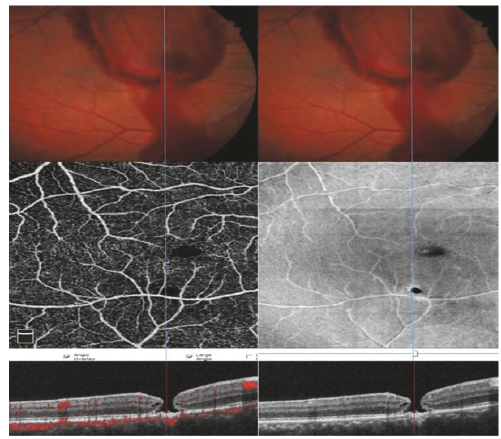
Figure 5: Theprojection of theevacuation of bloodfromsubhyaloid space and the full thickness retinal hole formation were same (blue line). Superficial vascular plexus was damaged at that